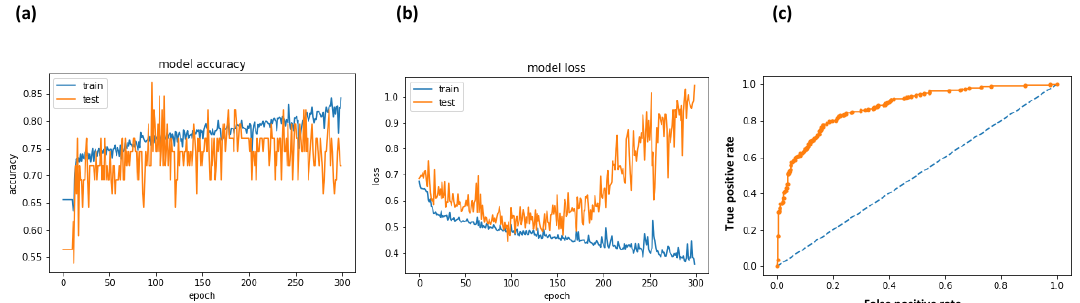
Figure 7. LSTM results (training dataset = 95%, testing dataset = 5%): ( a ) Model accuracy versus epochs; ( b ) model loss versus epochs; ( c ) receiver operating characteristics (ROC) curve.